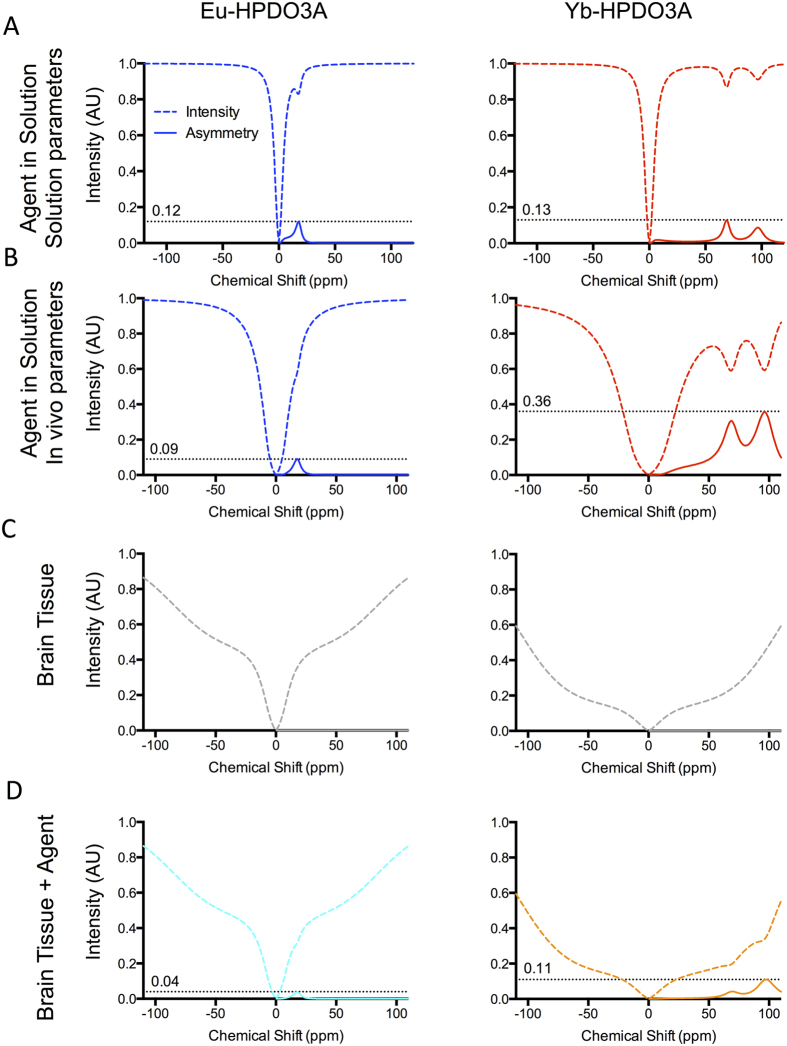
Magnetization Transfer (MT) effect simulation.(A) Numerical calculation of Bloch-McConnell equation shows similar z spectra to experimentally acquired data of agent in solution (1.5 s, 15 μT presaturation pulse for Eu, and 800 ms, 23 μT pulse for Yb). (B) When the pulses are altered (to 800 ms, 28 μT for Eu and 600 ms, 56 μT for Yb) to provide improved contrast in vivo, the water peak becomes wider, but contrast achieved for Yb is significantly increased. (C) MT effects in brain tissue further widen the water peak, (D) resulting in decreased agent contrast.